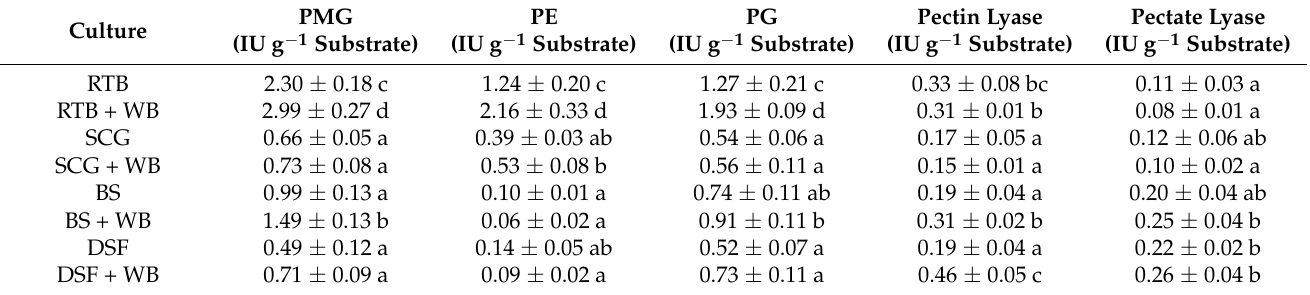
Table 5. Specific activities, referred to unit mass of the solid substrate, of polymethylgalacturonase (PMG), pectin esterase (PE), polygalacturonase (PG), pectin lyase, and pectase lyase in A. olivimuriae solid-state cultures conducted for 14 days at 301.15 K on residual thistle biomass (RTB), spent coffee rounds (SCG), barley straw (BS) e digestate solid fraction (DSF) in the absence and presence of wheat bran (WB). Data are the means ± standard deviation of 4 replicates. Multiple pair-wise comparisons were made with Tukey’s test, and identical letters denote that column means were not statistically different ( p >